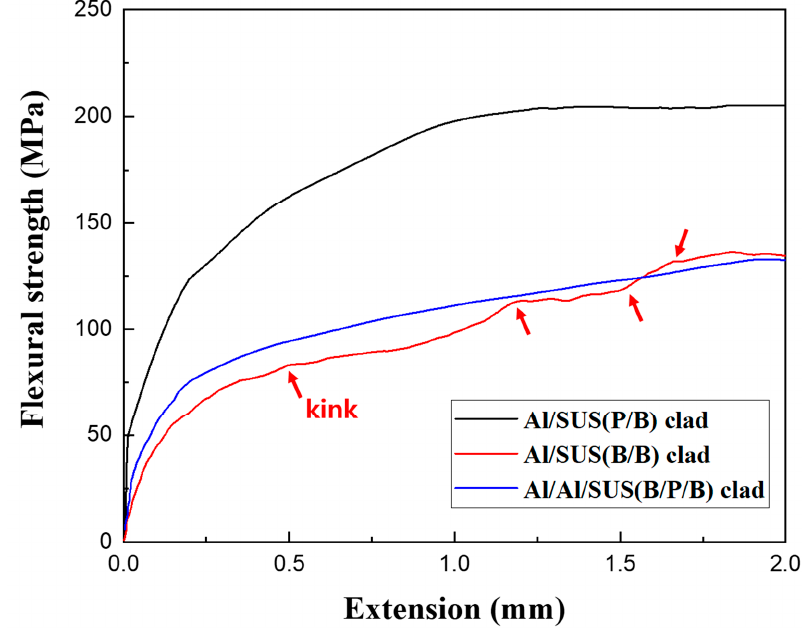
Figure 6. Flexural strength curves of Al/SUS clads determined via three-point bending test.